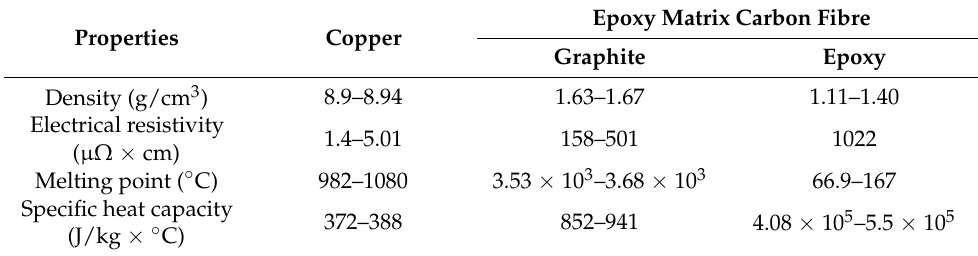
Table 2. Physicochemical properties of the materials